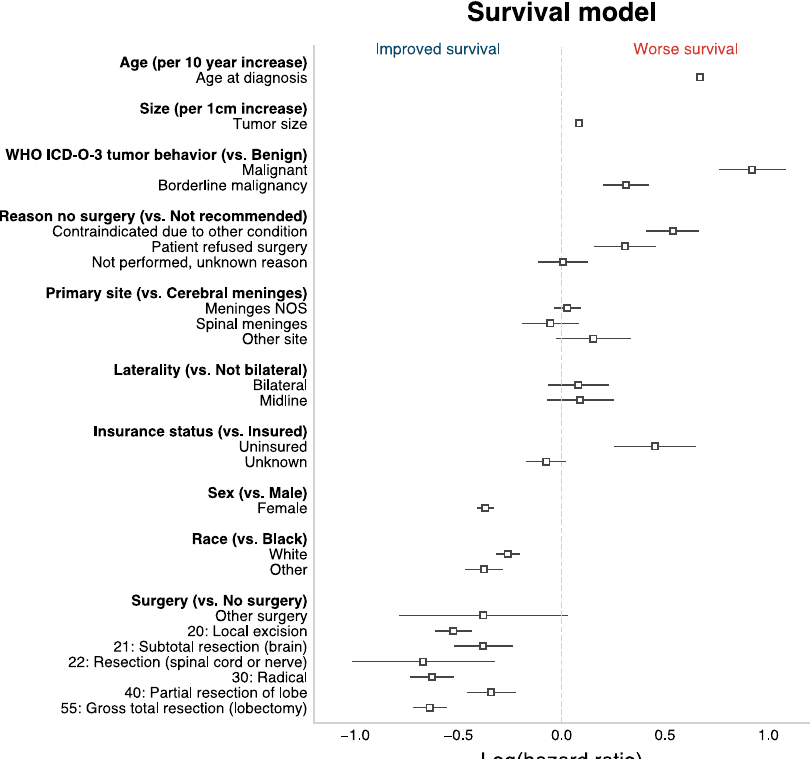
Fig. 2 Log hazard ratios for each of the features of the survival model. Negative values indicate proportionally lower probability of death. Positive values indicate proportionally higher probability of death. Error bars represent 95% con fi dence